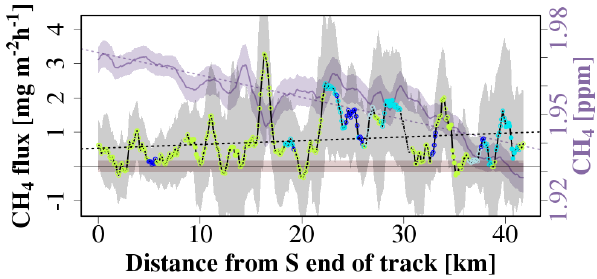
Figure 12. Space series of 399 observations of CH 4 concentra- tion (purple line) and flux (black line), each 100m, averaged over 1000m windows. The random sampling errors are indicated by the shaded areas enveloping each line, and the flux detection limit is shown as a salmon-colored envelope around the abscissa. Circles in- dicate the dominating land cover in the footprint of each observation (Fig. 11) with full circles corresponding to “pure” fluxes ( > 80% surface